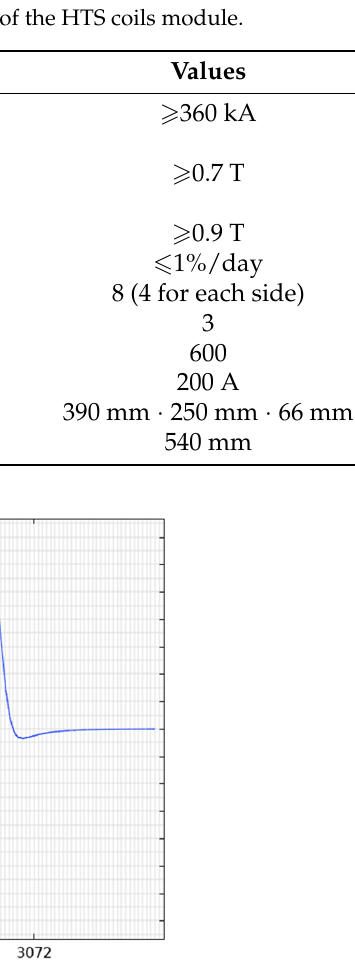
Figure 3. Axial B distribution on the central line 90-mm from the bottom surface of the HTS coils module.